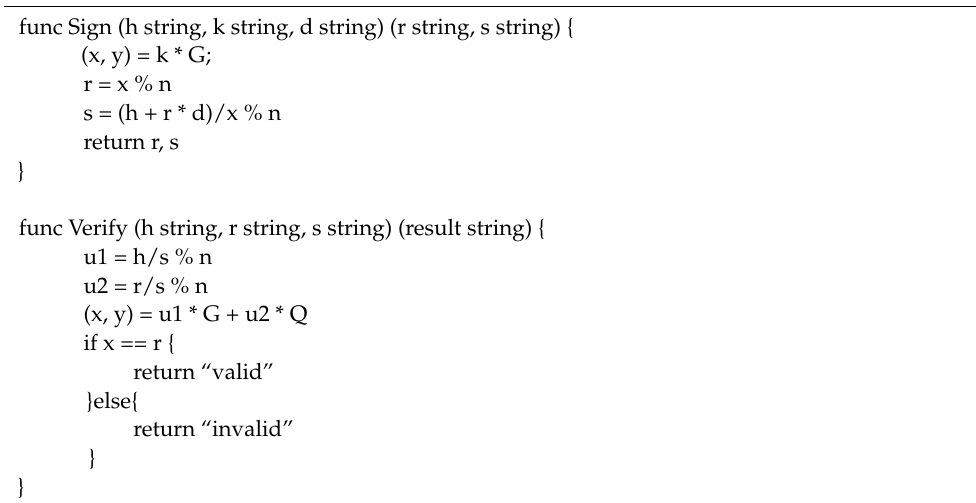
Algorithm 2. Authentication of the proposed